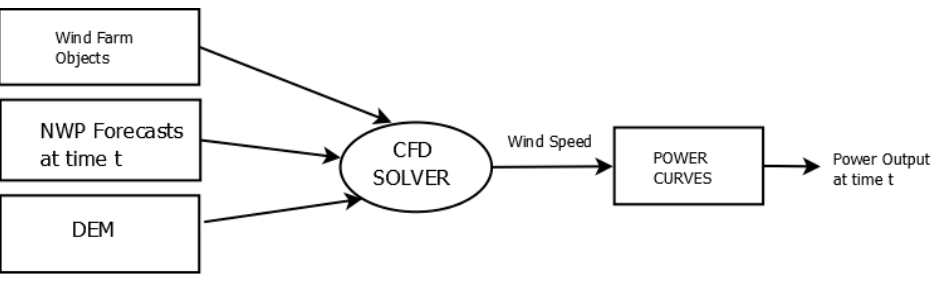
Figure 2. Input and output of physical method.